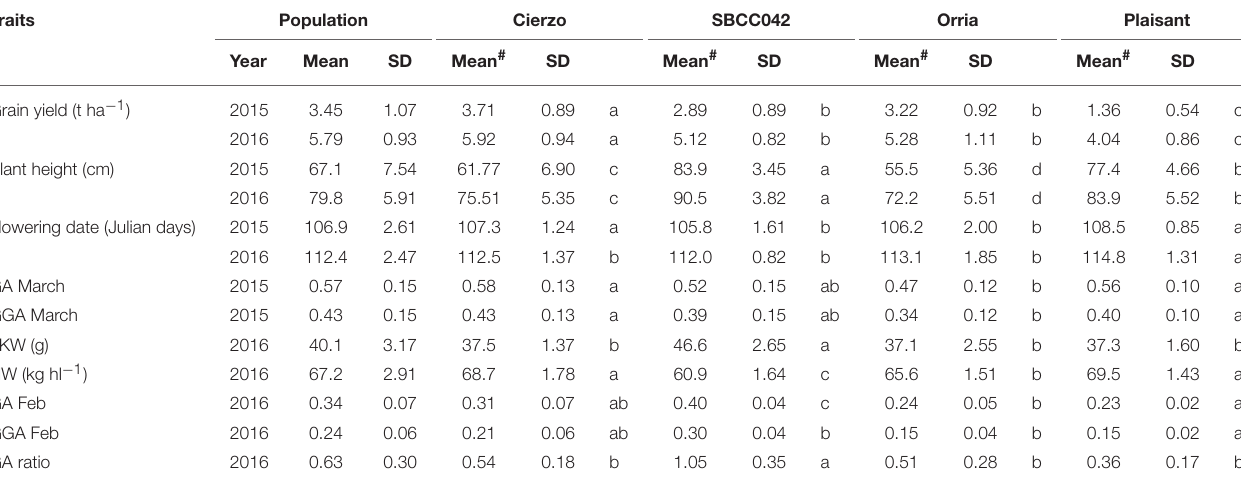
TABLE 1 | Trait averages for the SBCC042 × Cierzo population, parents, and checks. Traits Population Cierzo SBCC042 Orria